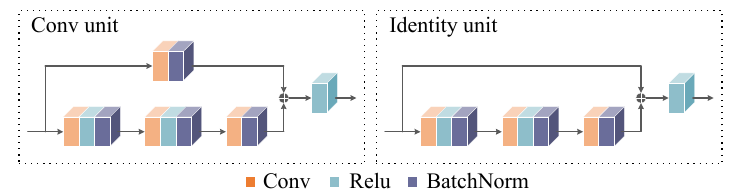
Figure 3. The basic residual network